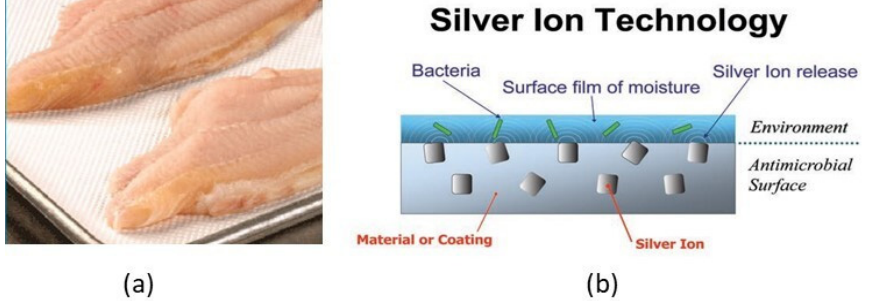
Figure 4. ( a ) Food-touch ® antimicrobial paper liner, ( b ) silver ion technology (Packaging Digest, Pharmaceutical Microbiology Resources) [103,104].